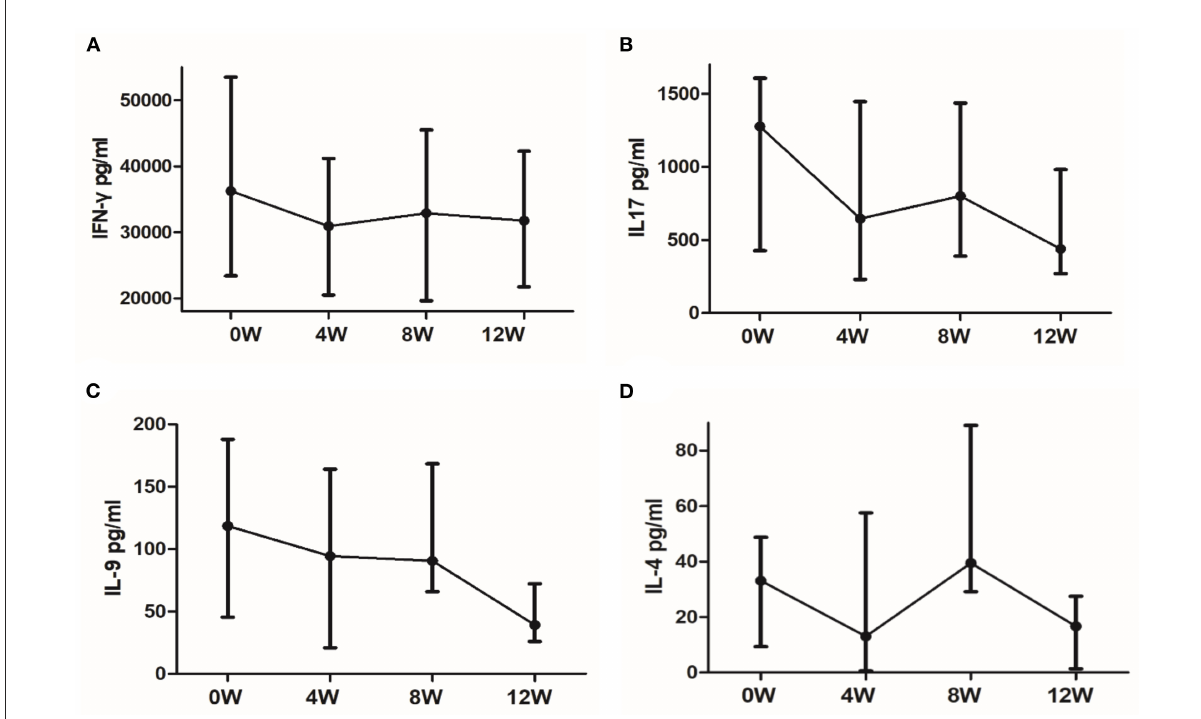
FIGURE5 Cytokines secretion trends in responsive patients. (A) IFN- γ , (B) IL-17, (C) IL-9, and (D) IL-4 secretion trends. The dots indicate the median. The horizontal bars indicate the quartiles.